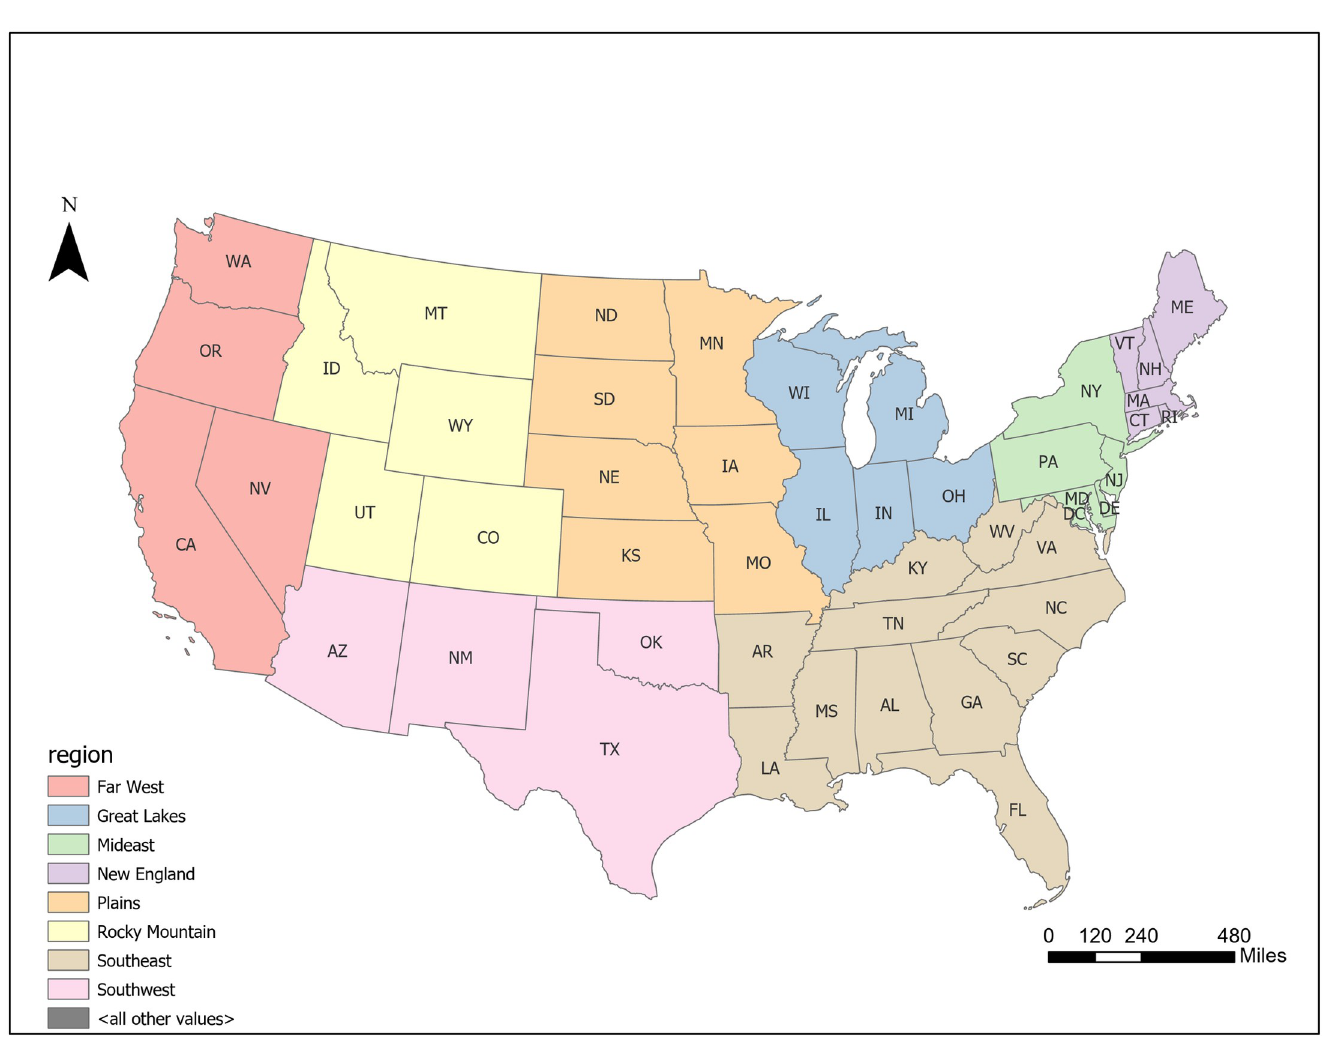
Fig 1. The eight U.S. economic regions defined by the Department of Commerce Bureau of Economic Analysis: New England, Mideast, Southeast, Great Lakes, Plains, Rocky Mountains, Southwest, and Far West.